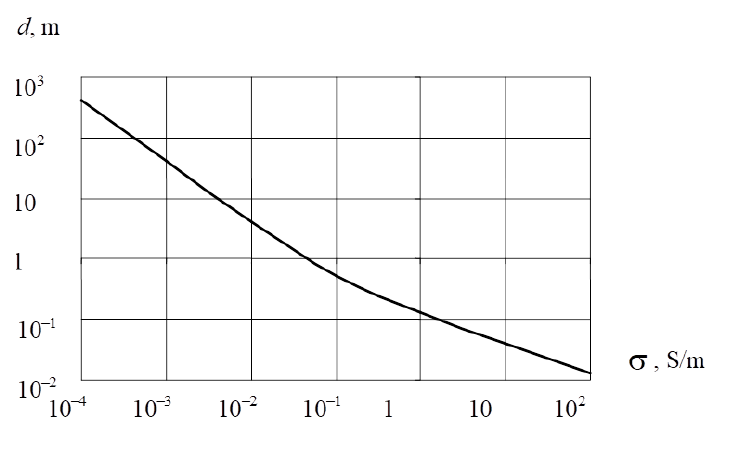
Fig. 5. Dependence of penetration depth on the conductivity of the